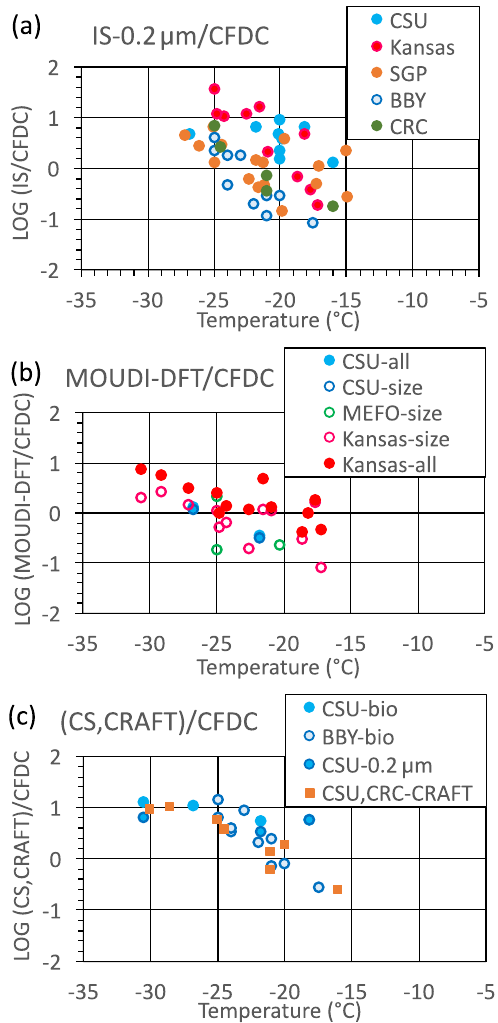
Figure 4. Base 10 logarithm of the ratio of INP number concen- trations measured by various immersion freezing methods vs. the CFDC at different sites, denoted as in previous figures. IS 0.2µm filter samples are shown in (a) from five sites. MOUDI-DFT data are compared from three sites in (b) , where “size” and “all” refer to whether INP number concentrations are from MOUDI size ranges overlapping with sizes permitted into the CFDC or from all sizes. CS and CRAFT ratios are shown in (c) , where all blue points are for the CS, and “bio” refers to BioSampler